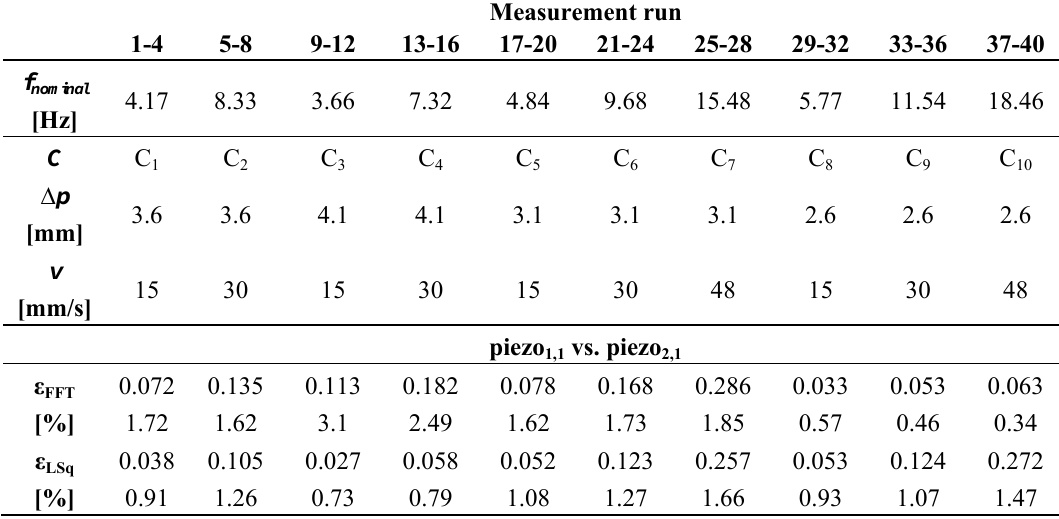
Table 3. Average RMS errors obtained by FFT ( ε using the full data range. The top row indicates the expected frequency, f on the measurement run. The combination C of spatial period ∆ p and velocity v associated to each measurement run is also